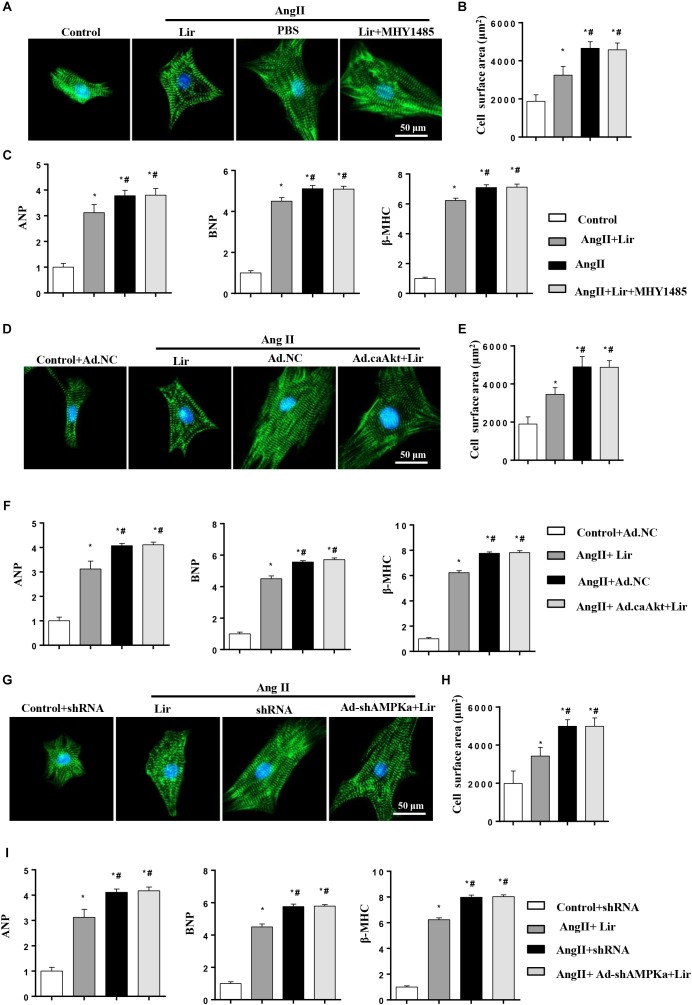
Lir attenuated hypertrophy of myocytes in an AMPKα-dependent manner in vitro. Cardiomyocytes were treated with AngII (1 μM) and Lir (30 μM) with/without MHY1485 (10 μM), Ad.caAkt or Ad-shAMPKa infection. (A,D,G) Representative immunofluorescent staining of α-actin in the indicated group (n = 6). (B,E,H) Quantitative analysis of CSA in the indicated group (n = 50 + cells per group). (C,F,I) RT-PCR analysis of the mRNA levels of ANP, BNP, and β-MHC in the indicated group (n = 6). ∗P < 0.05, compared to the control group (B,C)/Control + Ad.NC (E,F)/Control + shRNA (H,I); #P < 0.05, compared to the AngII group (B,C)/AngII + Ad.NC (E,F)/AngII + shRNA (H,I).